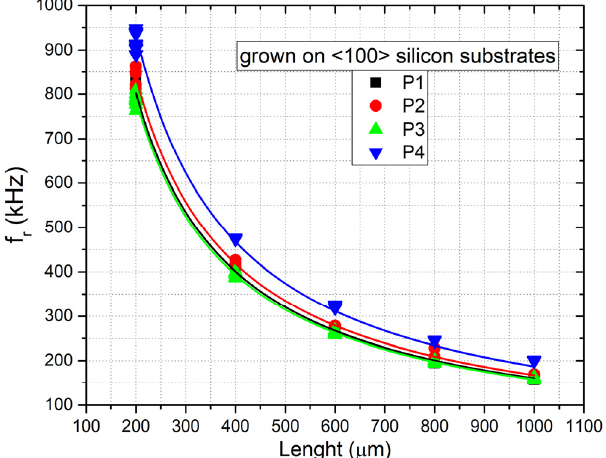
Figure 12. First-order resonance frequency versus length of the double clamped beams for the sam- ples with p-type doping grown on <100> silicon substrates. The continuous lines are the data fittings obtained with Equation (2).